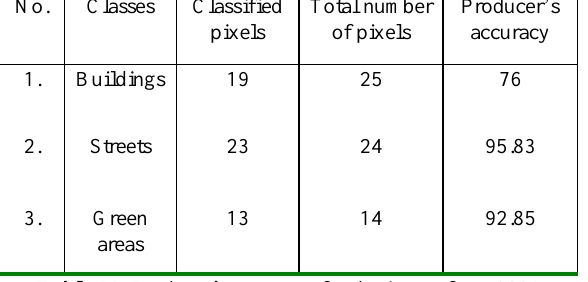
Table 7 . Omission error for the image from 2021 No.